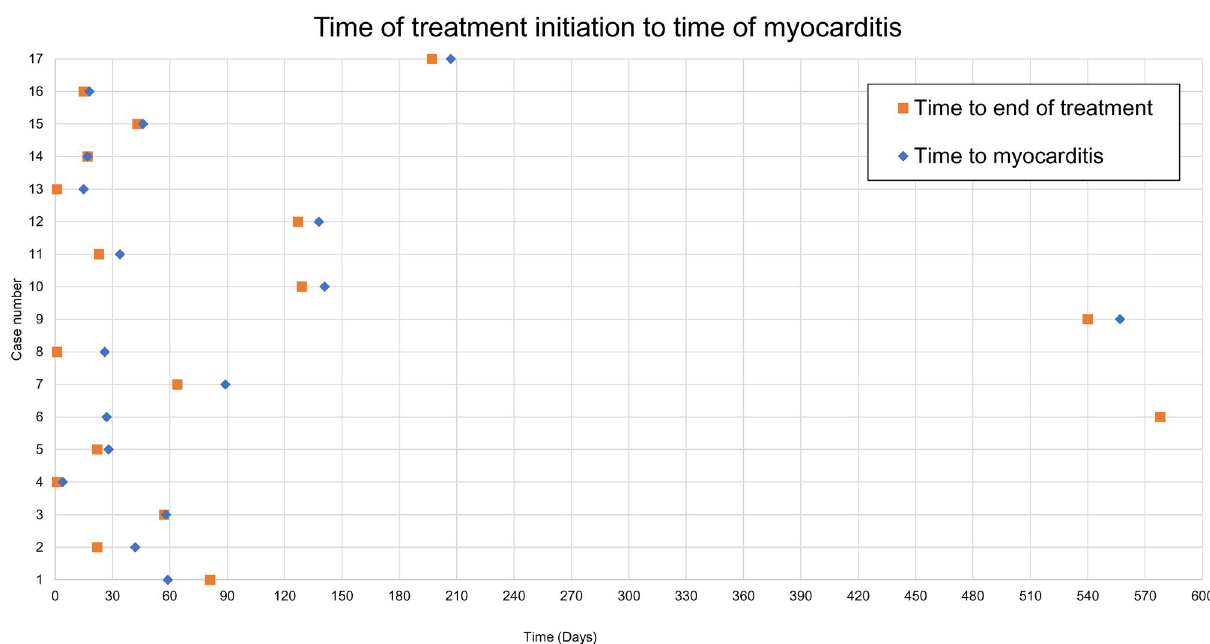
Figure 3. Visualization of the time to end of treatment due to an AE and time to myocarditis X-axis represents the cases numbered in Table 2.